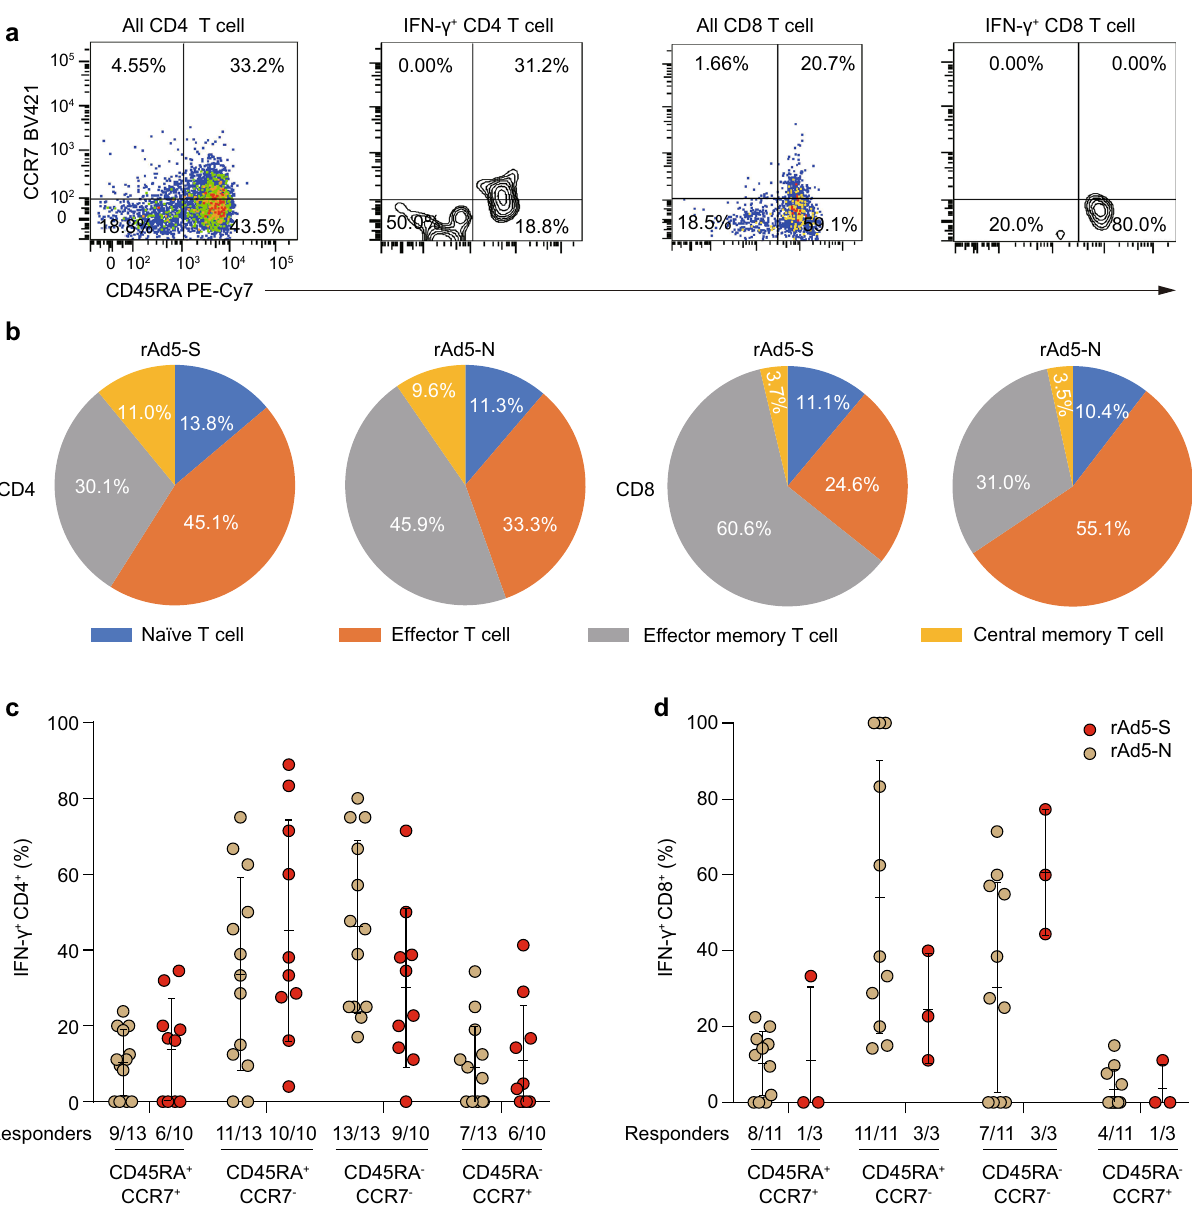
Fig. 4 Phenotypic memory of SARS-CoV-2-speci fi c T cells in recovered COVID-19 patients 3 – 4 months after infection. Phenotypic memory (naive, CD45RA + CCR7 + ; central memory, CD45RA − CCR7 + ; effector memory, CD45RA − CCR7 − ; and late effector, CD45RA + CCR7 − ) analysis of IFN- γ - secreting CD4 + and CD8 + T cells. a FACS plot examples of CD45RA and CCR7 expression on all CD4 and CD8 T cells and recombinant replication- de fi cient adenovirus type 5 that encodes nucleocapsid protein (rAd5-N) -speci fi c IFN- γ -secreting CD4 + and CD8 + T cells. b The constitution ratio of naive, central memory, effector memory, and late effector T cells on virus-speci fi c IFN- γ -secreting CD4 + and CD8 + T cells of recovered patients 3 – 4 months after infection. Data on rAd5 that encodes green fl uorescent protein (rAd5-GFP) controls are not shown because few virus-speci fi c cytokine-secreting T cells were detected. c – d The percentage of rAd5-S- and rAd5-N-speci fi c memory T cells in CD4 + ( c ) and CD8 + ( d ) T cells in recovered patients 3 – 4 months after infection. Data are presented as mean ± SD. The two-tailed Mann – Whitney U -test was used for c and d . Source data included as a Source Data